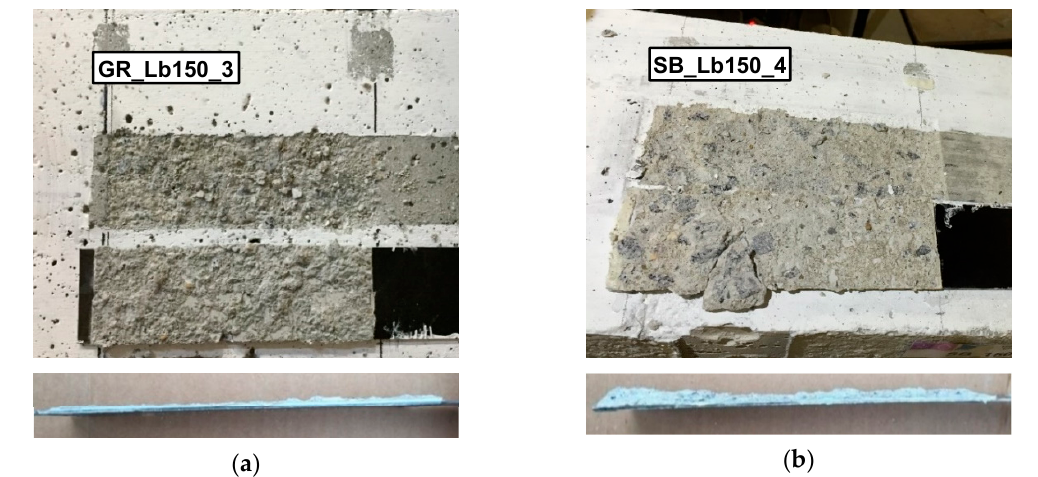
Figure 6. Fracture surface of carbon fiber reinforced polymer (CFRP)/concrete after debonding for different surface preparation methods: ( a ) grinding; ( b ) sandblasting.